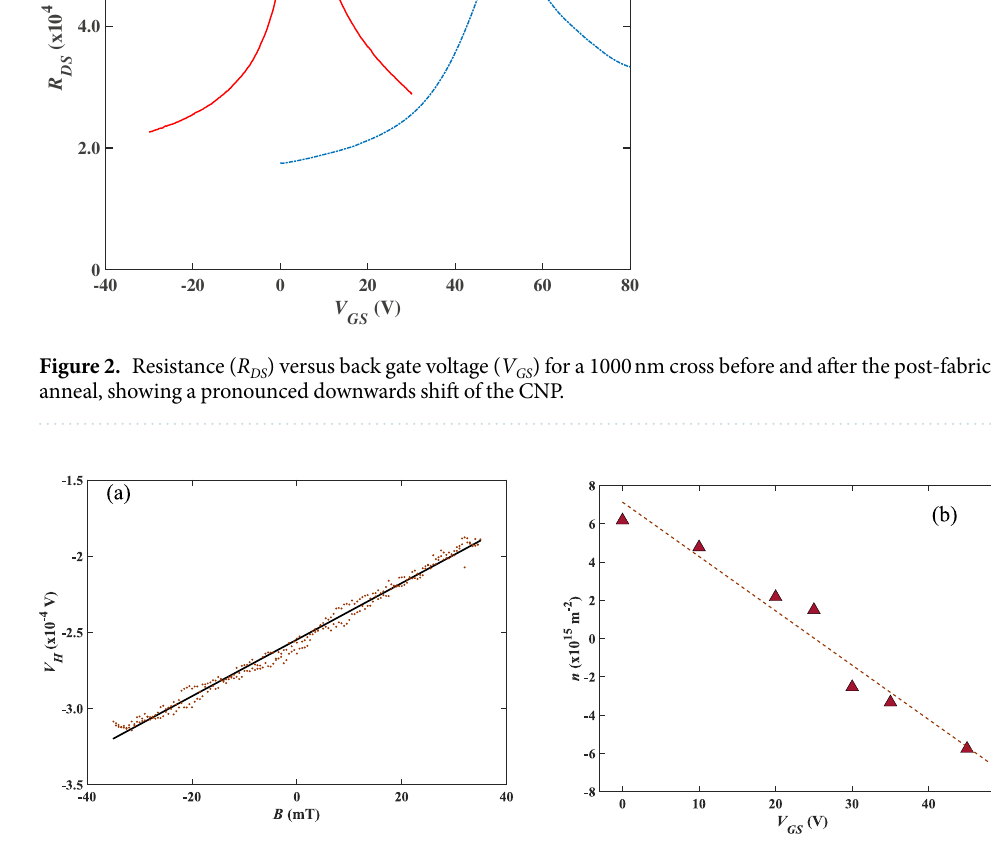
Figure 3. ( a ) A typical Hall voltage versus magnetic field trace at I H = 10 µ A for a 700 nm cross. ( b ) The carrier density, n , calculated from measurements of R H as a function of V GS for a 700 nm Hall cross with the CNP located at V D = 27 V. The dotted line represents a linear fit to Eq. (9).